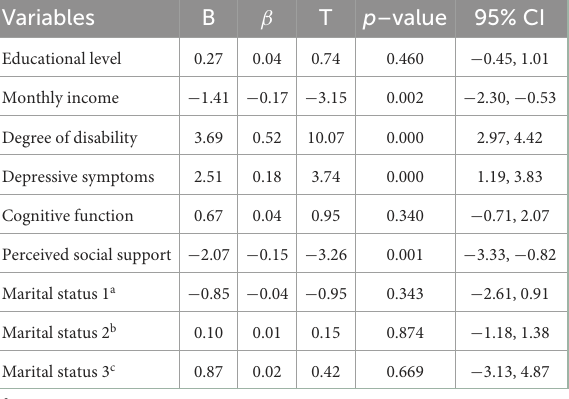
TABLE 3 Predictive factors of self–neglect according to the multiple linear